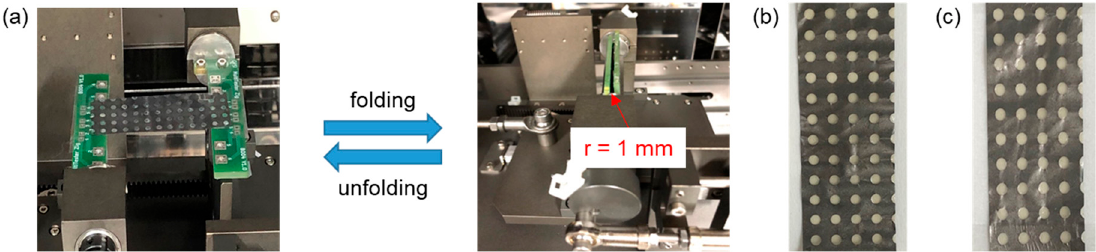
Figure 6. ( a ) Photos of the unfolded and folded g − TC films during the U-folding tests; photos of the g − TC films ( b ) before and ( c ) after 10,000 cycles of the U-folding tests .